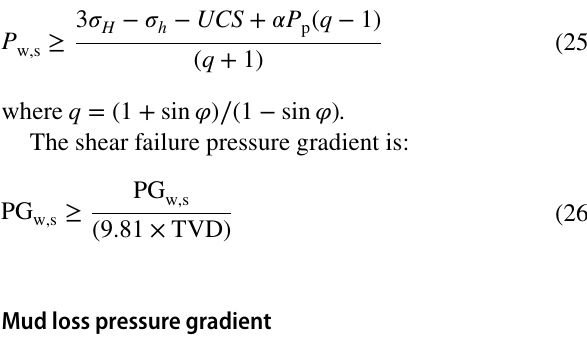
Table 14 Tensile failure pressures for different tensile failure modes (Simangunsong et al. 2006; Zhang et al. 2006)